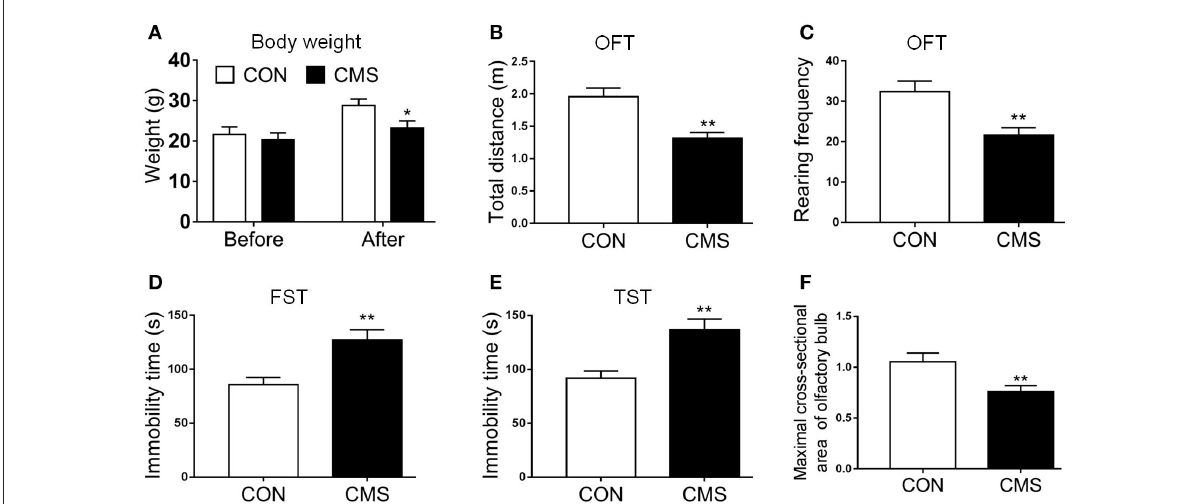
FIGURE2 Evaluating the results of the CMS depression model. (A) Body weight before and after the CMS; (B,C) Total distance of central zone and rearing frequency in OFT; (D,E) The immobile time in FST and TST; (F) Olfactory bulb maximal cross-sectional area and diameter. Data are expressed as means ± S.E.M. * P < 0.05, ** P < 0.01 as compared with control group. CMS, chronic mild stress; OFT, open field test; TST, tail suspension test; FST, forced swimming test. n = 15 for weight and behavior test and n = 3 for olfactory bulb maximal cross-sectional areas and